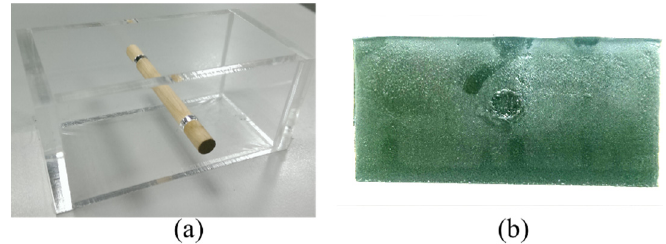
Figure 8. ( a ) A mold for constructing the block shaped phantom; ( b ) Phantom.